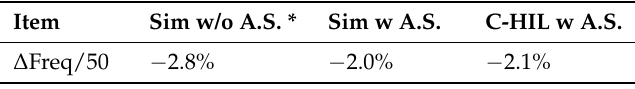
Figure 9. Frequency transients under the load disconnection. In yellow, we show the simulation without regulation. In blue, we show the simulation with regulation in the C-HIL case and in orange, we show the pure real-time simulation. The blue simulation highlights how the presence of the sampling done by the controller introduces numerical instabilities that move away from the ideality of pure simulation. These oscillations must be taken into account in the optimal design phase of the control system. Table 4. Frequency overshooting under load connection.